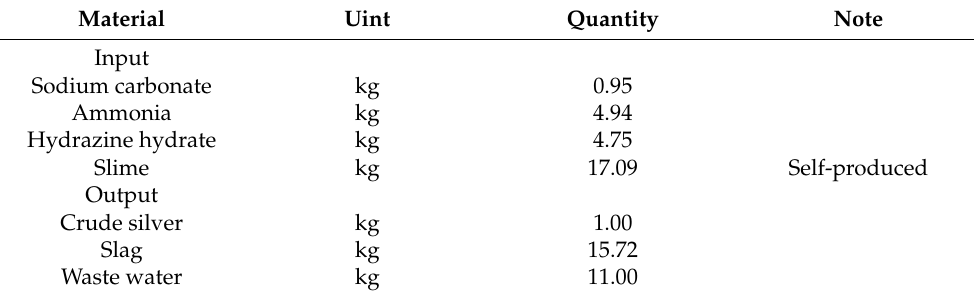
Table 1. Material inventory of original silver separation process.